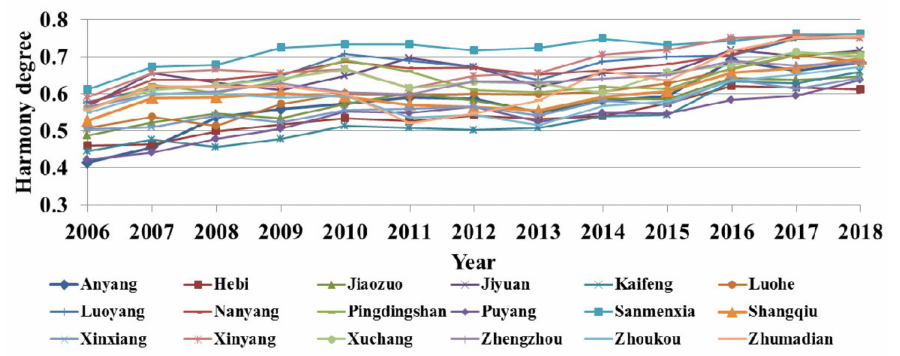
Figure 3. Temporal variation of human–water harmony degree in Henan Province from 2006 to